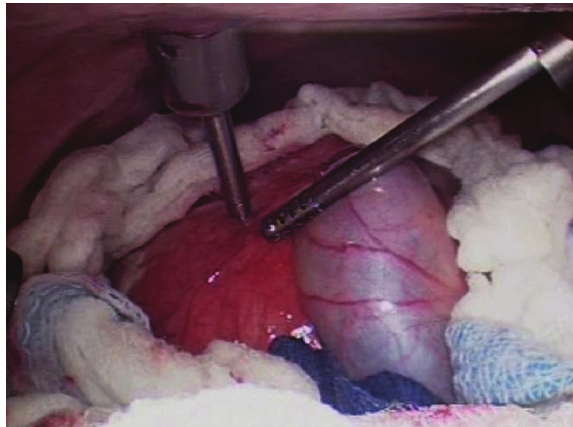
Figure 4: Aspiration of cyst contents and instillation of hypertonic